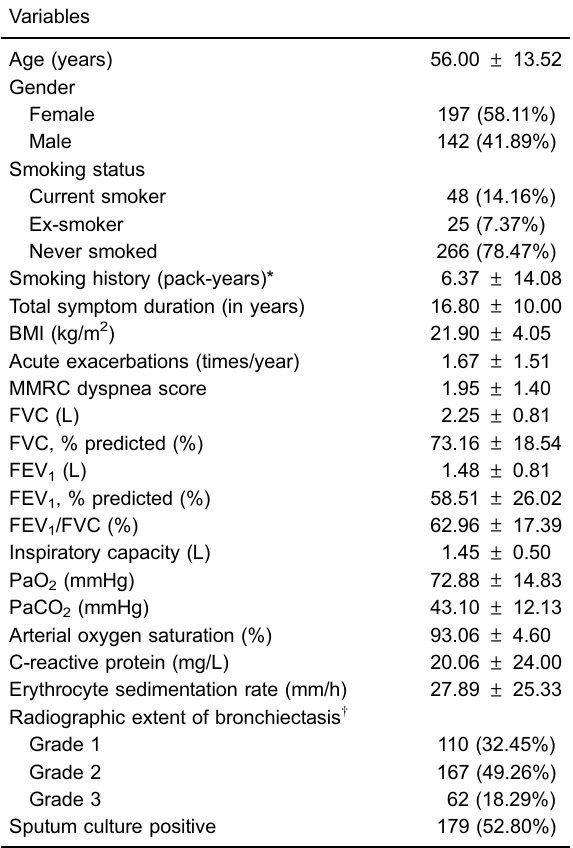
Table 2. Underlying etiology of 339 patients with non-cystic fi brosis bronchiectasis.